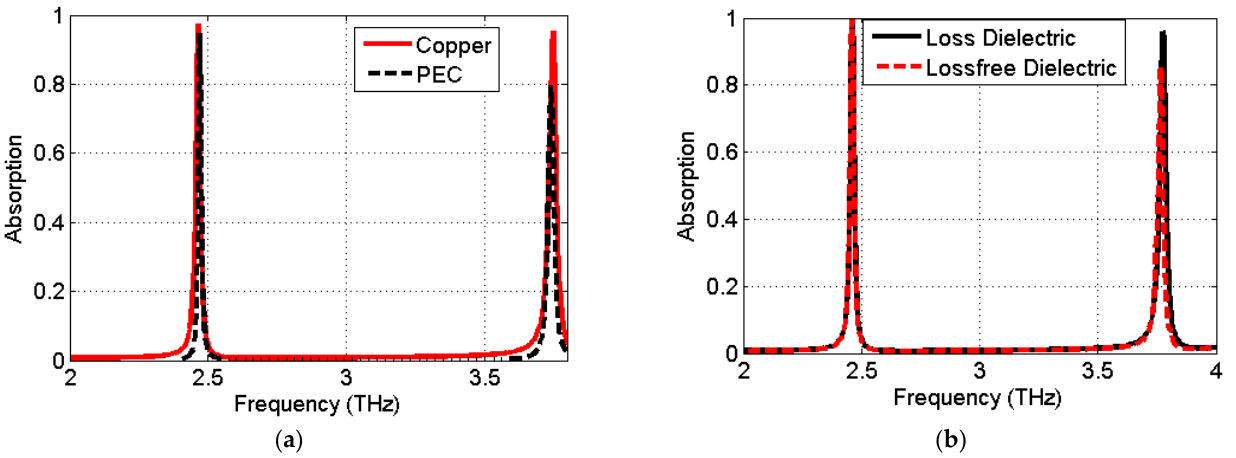
Figure 4. Absorption spectra of the proposed absorber obtained by HFSS for ( a ) the metallic layer implemented with PEC and copper. ( b ) Effect of the dielectric loss on the performance of the absorber. The geometrical parameters of the absorber are L = 40 µ m, w = 20 µ m, t s = 30 µ m and t m = 2 µ